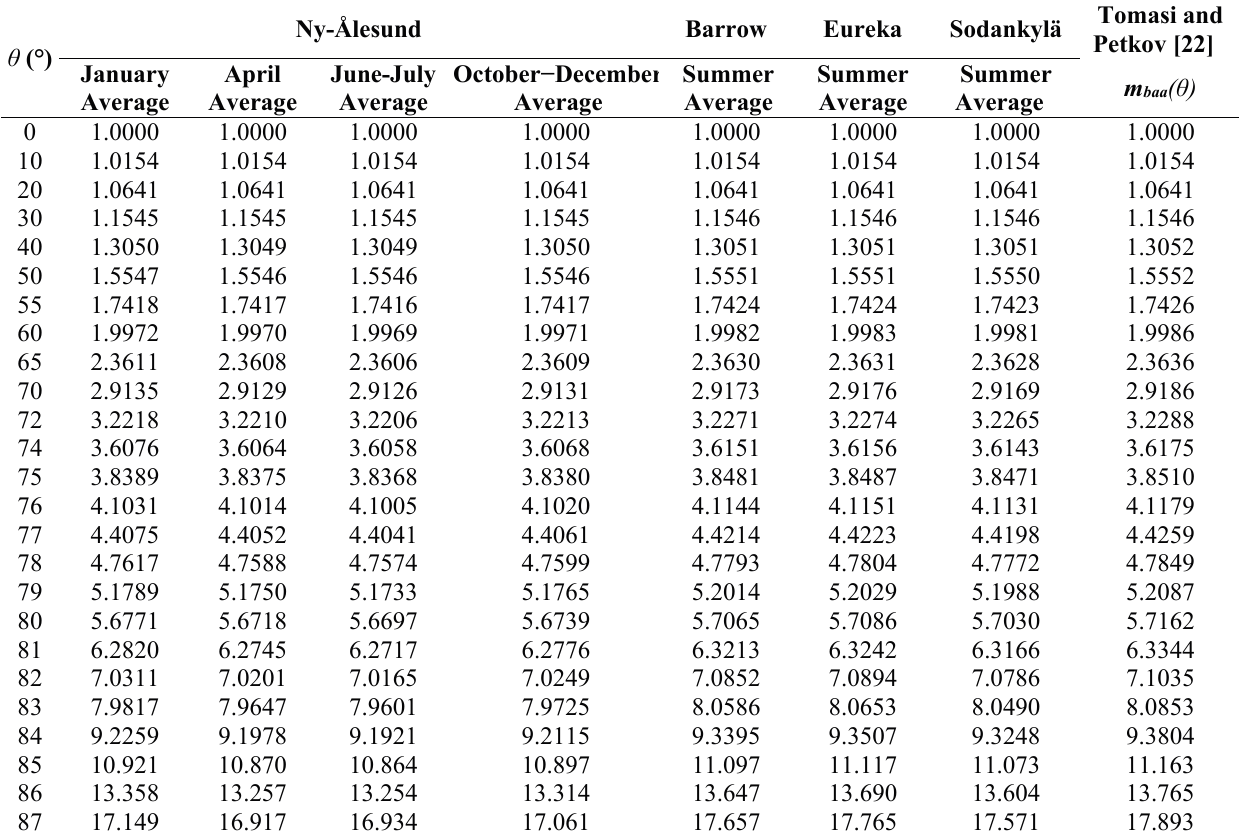
Table 2. Values of the relative optical air mass functions m a ( θ ) calculated for 25 selected values of apparent solar zenith angle  θ ranging from 0° to 87°, as obtained in the present study for background summer Arctic aerosol using as weight functions in Equation (3) the average vertical profiles of k a ( z ) shown in Figure 2 for Ny-Ålesund in April, June–July and October of 2013, and in Figure 3 for Barrow, Eureka, and Sodankylä, obtained by averaging the CALIPSO data collected during the summer months from June to October of the last 2 years. The present results are compared with the TP2014 [22] evaluations of relative optical air mass function m baa ( θ ) determined at Ny-Ålesund for background Arctic aerosol in summer, which are reported in the last column for